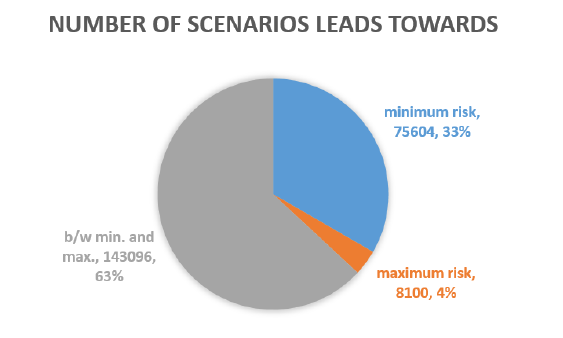
Figure 14. Classification of risk scenarios in dataset.